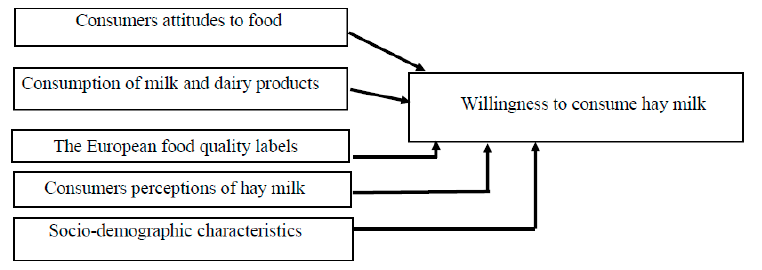
Figure 1. Conceptual framework.